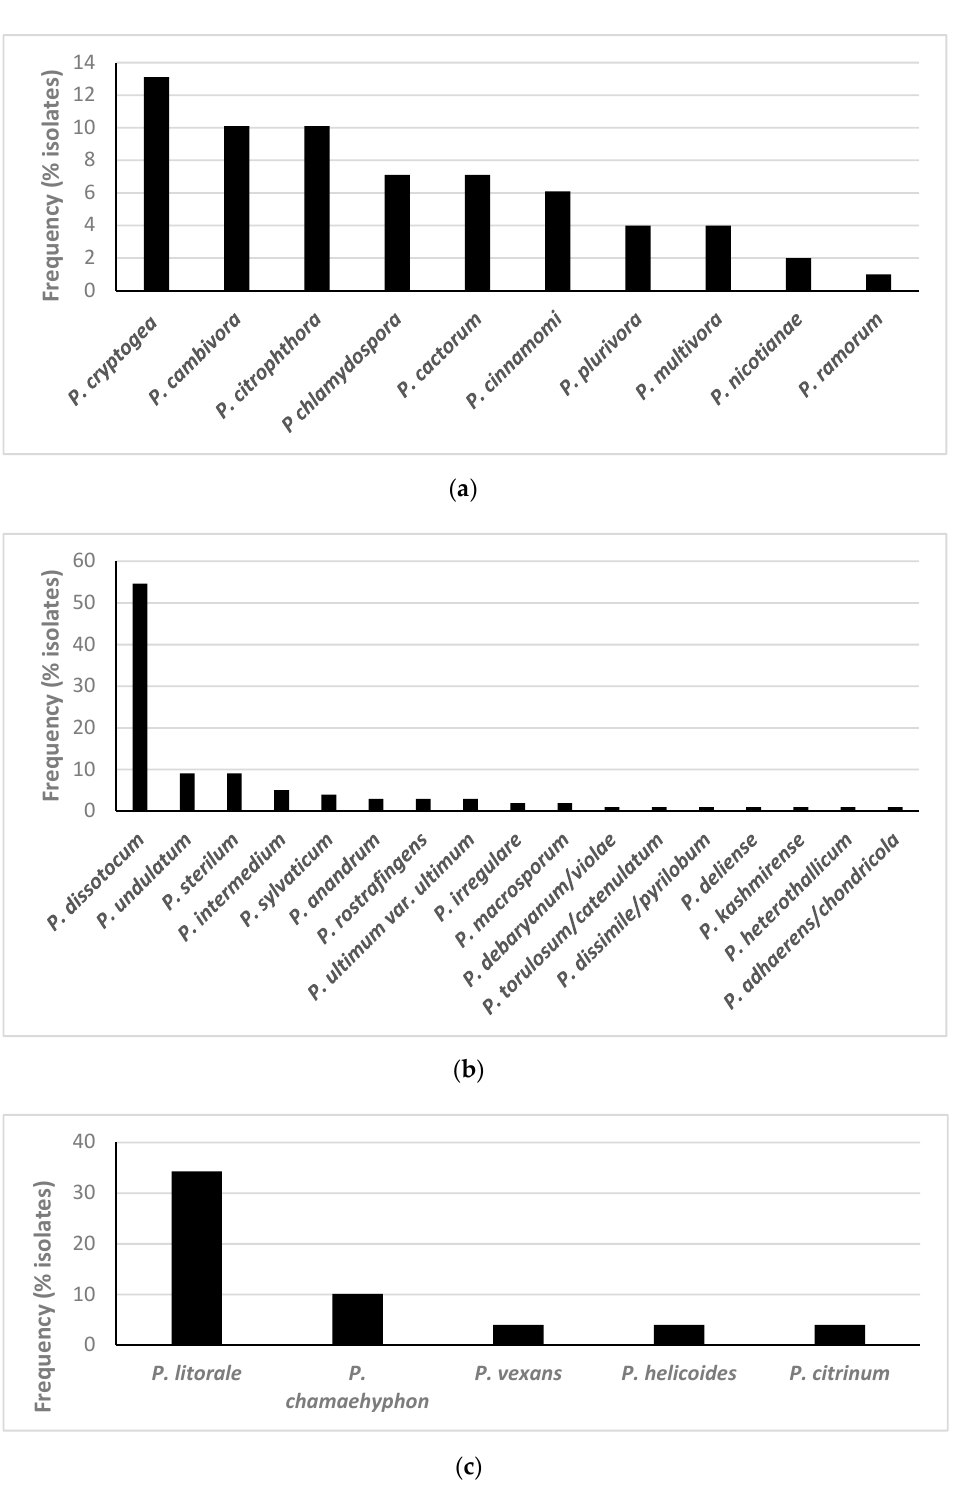
Figure 2. Frequency of isolation of species of ( a ) Phytophthora , ( b ) Pythium and ( c ) Phytopythium using classical methods from roots, composts and baitings from the 99 plants analysed.